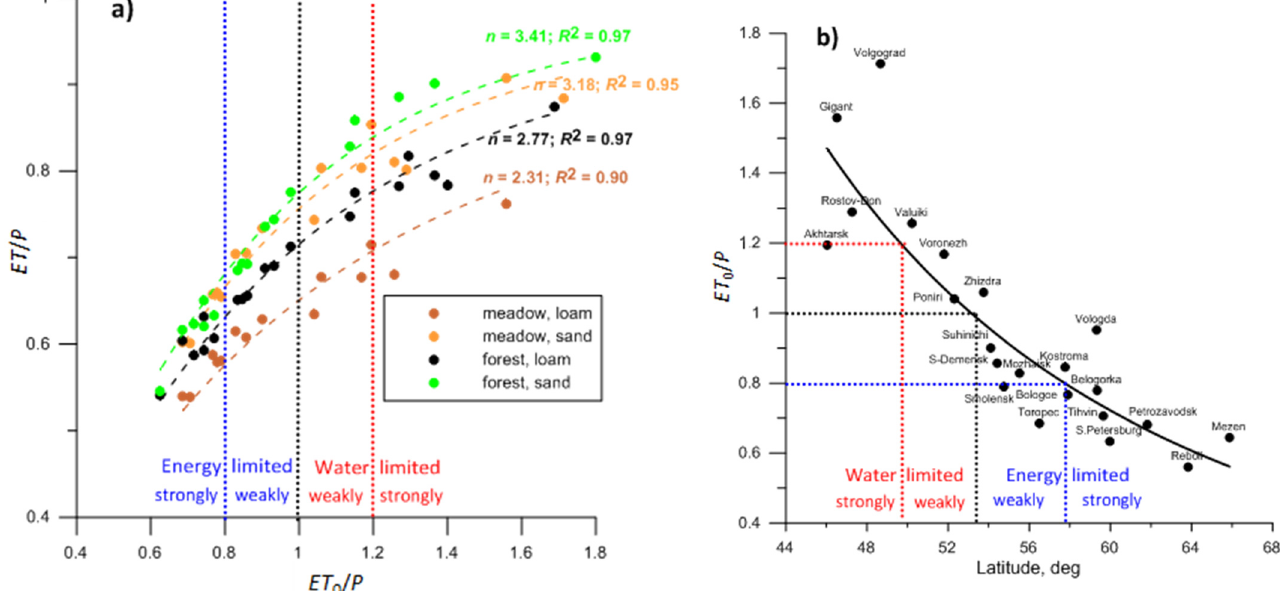
Figure 3. Annual evaporation ratio ( ET / P ) as a function of the annual ET 0 / P index for four simulated landscapes ( a ) and dependence of ET 0 / P for different weather stations on latitude ( b ). The dashed lines on graph (a) are Fu’s equation with the fitted n values using the least-square method. Dotted lines are boundaries for water and energy limited conditions.